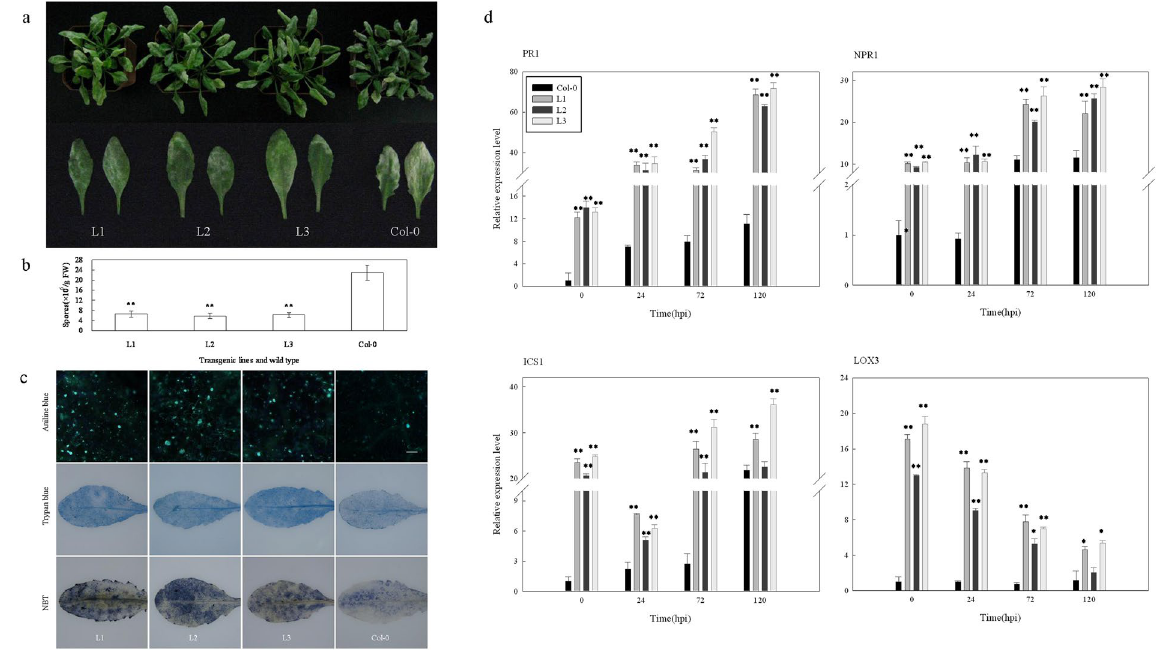
Figure 4. Response of VqTLP29 over-expressing Arabidopsis thaliana lines to powdery mildew inoculation. ( a ) Phenotypes of the 4-week old VqTLP29 transgenic line L1, L2, L3 and Col-0 infected with powdery mildew and disease symptoms in representative rosettes after inoculation for 7 days. ( b ) The number of spores per gram fresh leaf 7 days post powdery mildew inoculation. Spore suspensions of the VqTLP29 transgenic lines and Col-0 were diluted in sterile water with 10 diseased leaves and counted using the hemocytometer. Data were combined and analyzed as a one-way ANOVA in three independent experiments. Asterisks indicate statistical significance ( ** P < 0.01). ( c ) Callose deposition, cell death and O 2 − accumulation in the VqTLP29 transgenic lines and Col-0 7 days post powdery mildew inoculation. Three infected leaves of the transgenic lines and Col-0 were required for each stain in three independent experiments. The scale bar in the figure showing aniline blue staining indicates 100 μ m. ( d ) Expression levels of disease resistance genes in the VqTLP29 transgenic lines and Col-0 at 0, 24, 72 and 120 hpi following powdery mildew inoculation. Asterisks indicate statistical significance ( * 0.01 < P < 0.05, ** P < 0.01, one-way ANOVA). The experiments were repeated three times with consistent